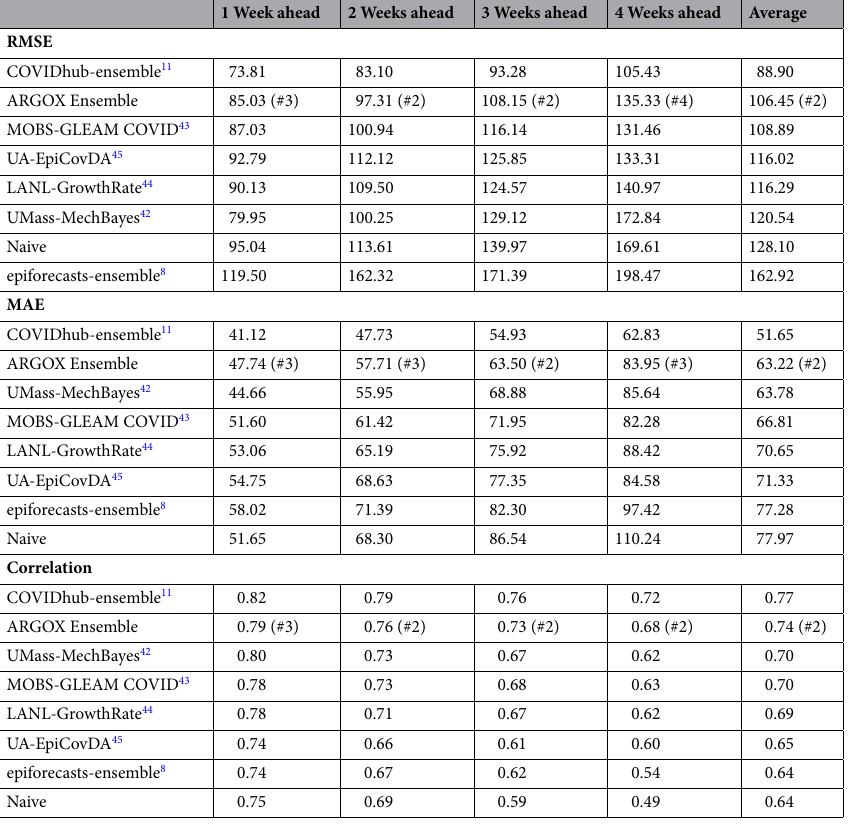
Table 5. Comparison among different models’ 1 to 4 weeks ahead U.S. states level weekly incremental death predictions (from 2020-07-04 to 2022-03-05). The RMSE, MAE, Pearson correlation and their averages are reported. Methods are sorted based on their average. Our ARGOX-Ensemble’s rankings for each error metric are included in